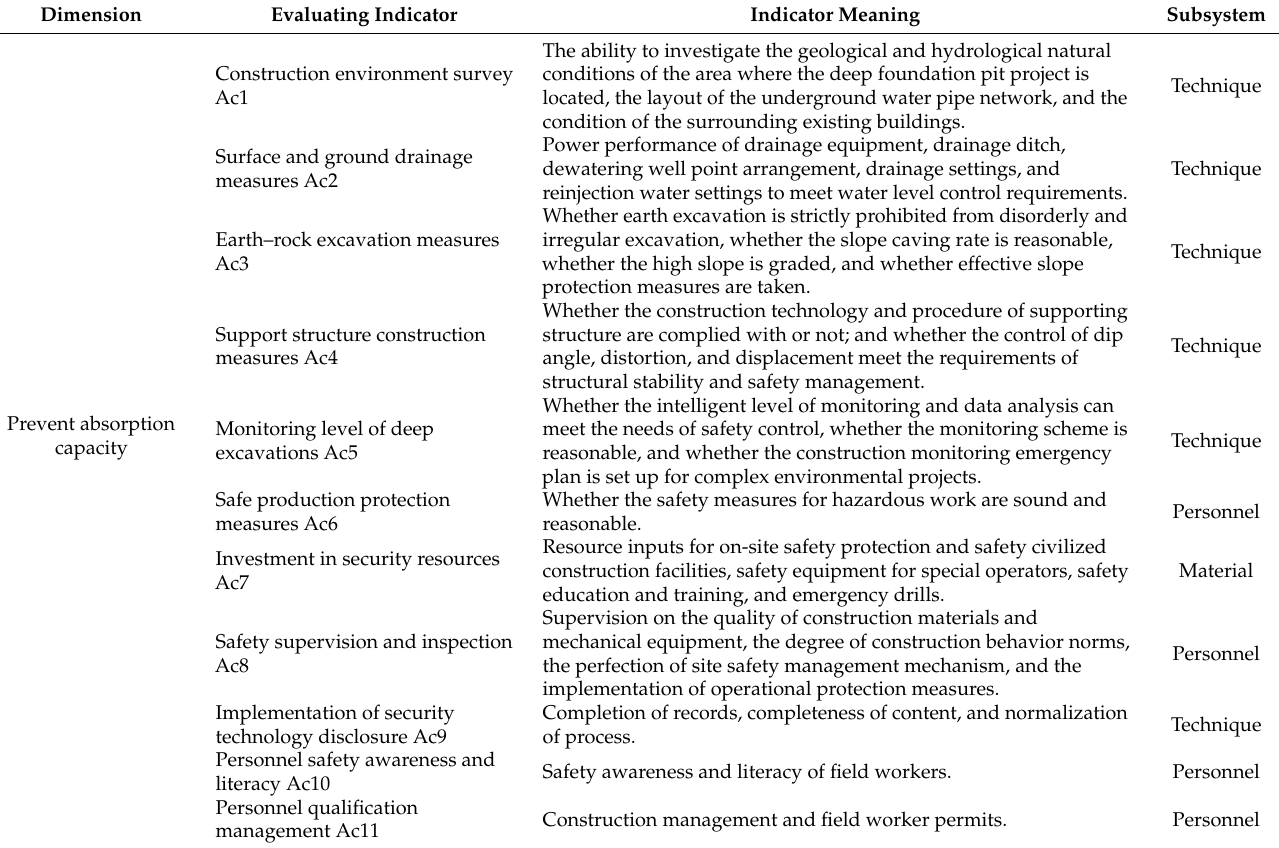
Table 3. Resilience evaluation index system of deep excavations construction safety